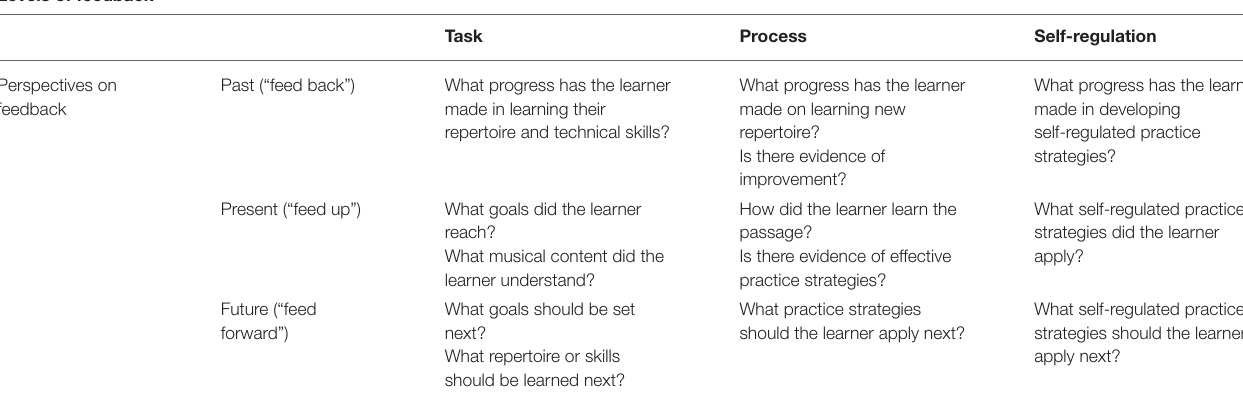
TABLE 1 | Levels of feedback. Levels of